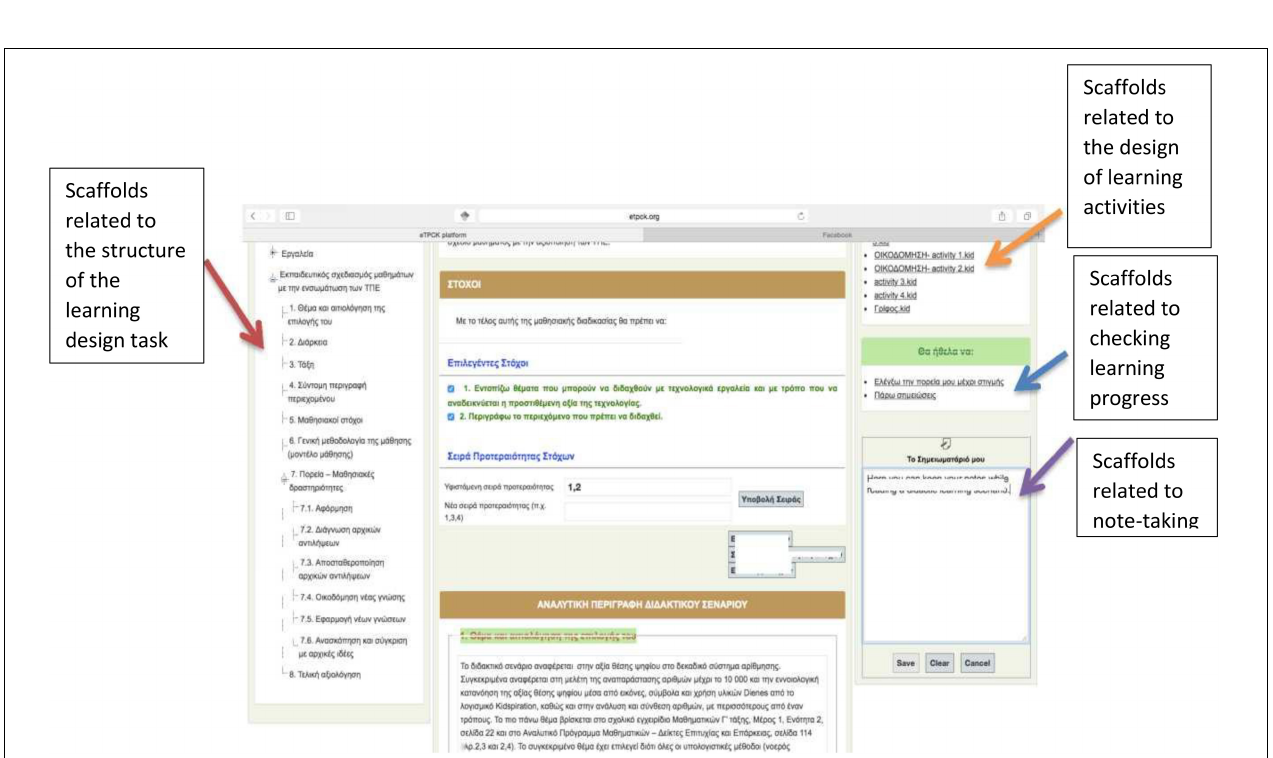
FIGURE 5 | Scaffolds in the instructional design space of the e-TPCK